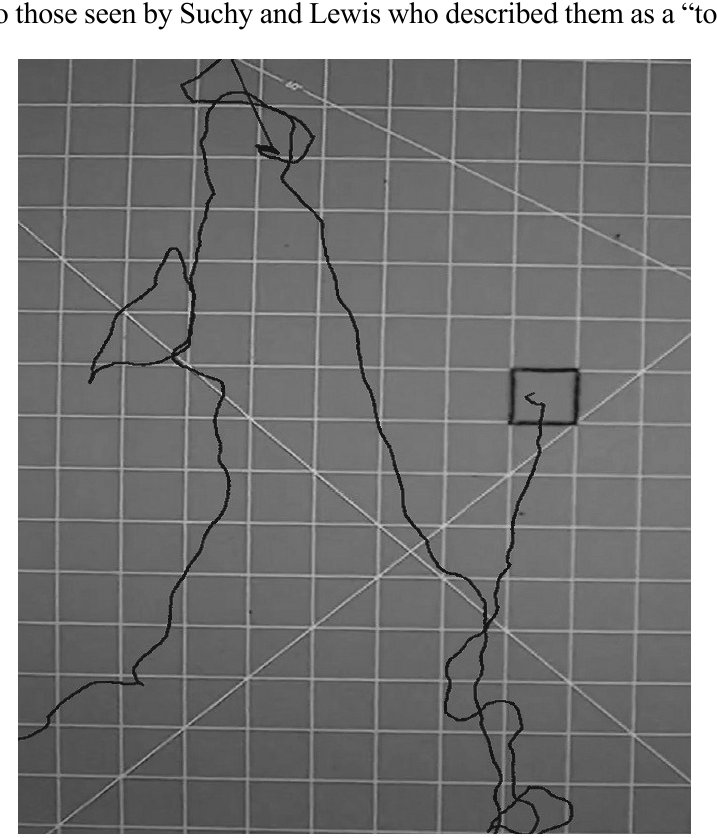
Figure 3. Typical bed bug searching pattern observed within the two-dimensional arena as plotted using time-lapse photography (this was the track of an unfed